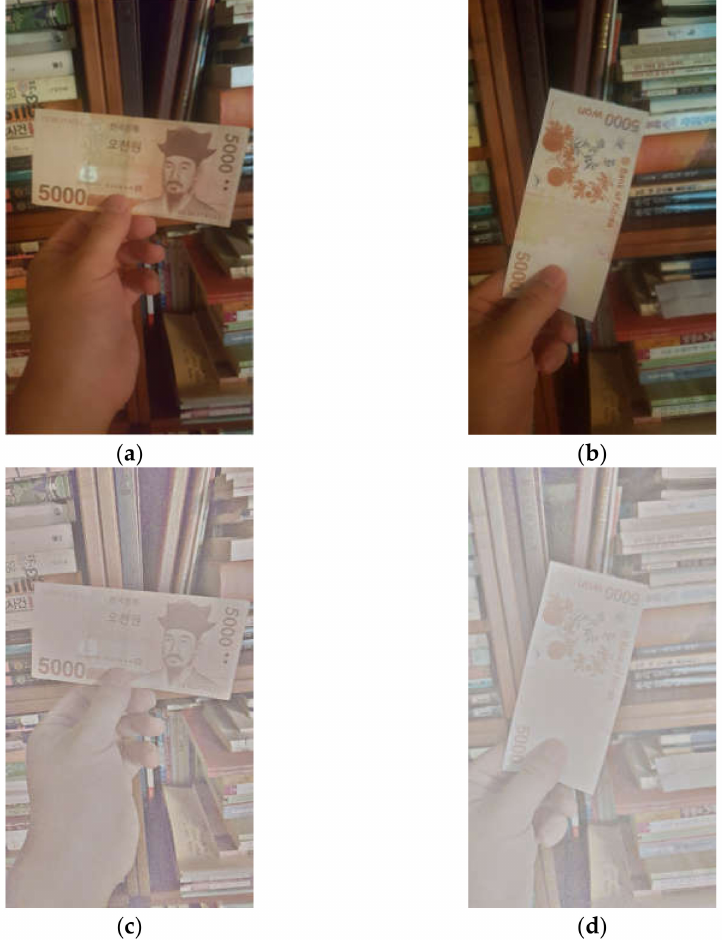
Figure 2. Example of banknote images captured from the ( a ) front side and ( b ) back side; ( c ) and ( d ) are the corresponding pre-processed images using